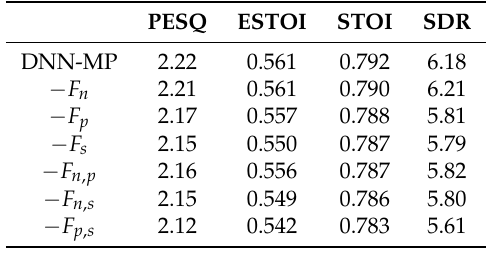
Table 3. Experiment 3-1: Effect of specific feature on DNN-MP. PESQ ESTOI STOI SDR DNN-MP